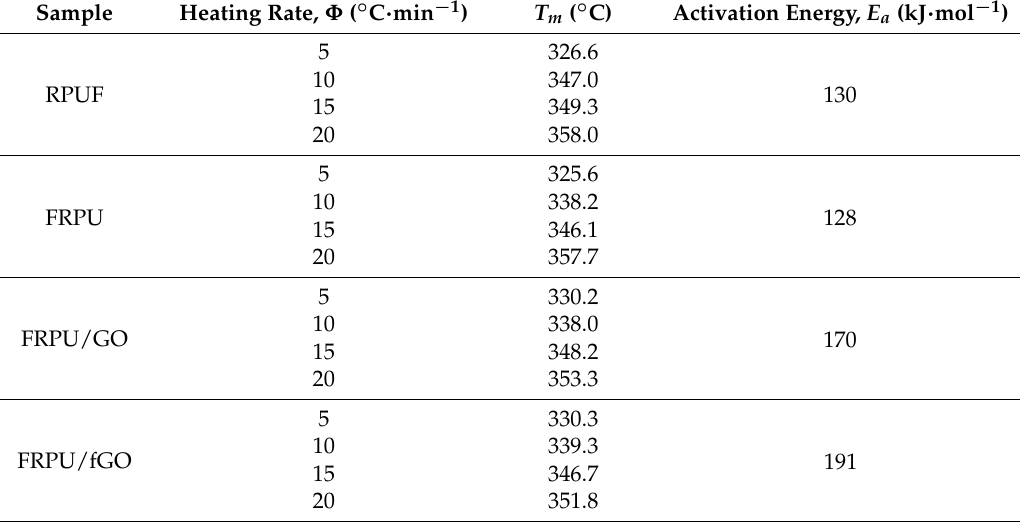
Table 3. Activation energies ( E a ) of the RPUF